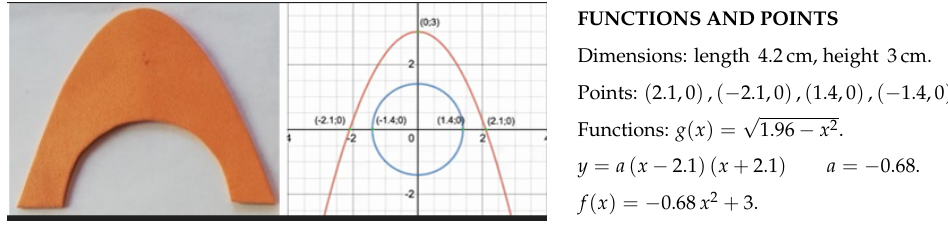
Figure 7. Q2—Desmos use—function and graph, example 4.